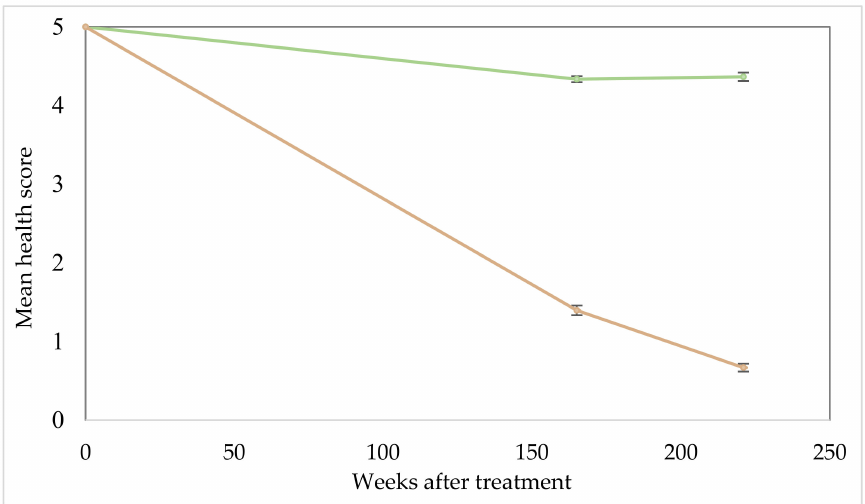
Figure 6. South parkinsonia infestation overall health score over trial duration (0, 165 and 221 WAT). Treated plants (gold), untreated control plants (green). Health score ratings, 5 = highest health score (>95% alive); 4 (71–95% alive); 3 (51–70% alive); 2 (31–50% alive); 1 (<30% alive); 0 (tree assessed as dead). Error bars represent ± standard error of